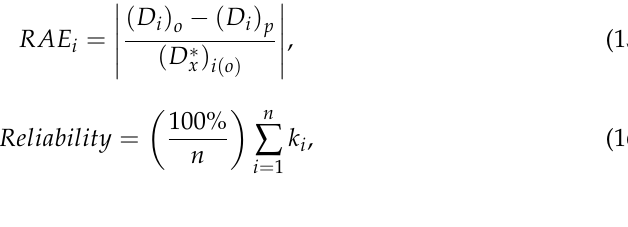
Table 5. The U95 for the proposed models. Forecasting Time (Hours-Ahead) Module